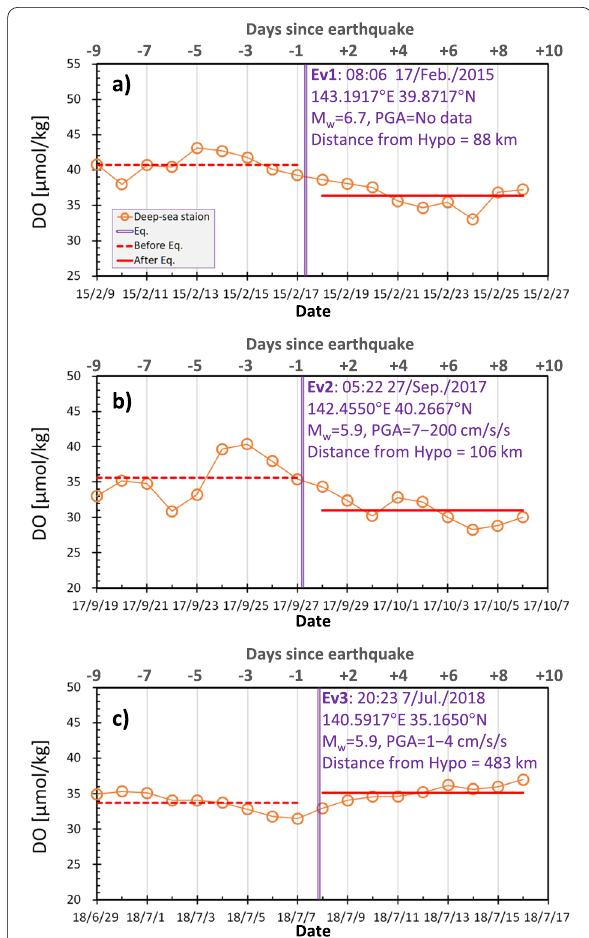
Fig. 6 Time series of DO in the bottom water at the deep-sea station (~ 1000 m depth) off Otsuchi Bay (Fig. 1a) before and after the events of the large earthquakes (purple double lines): February 17, 2015 (Ev1, Fig. 1a), September 17, 2017 (Ev2, Fig. 1a), and July 7, 2018, off then Boso Peninsula (Ev3). Dashed and bold lines refer to the 9-day mean values before and after the large earthquakes,